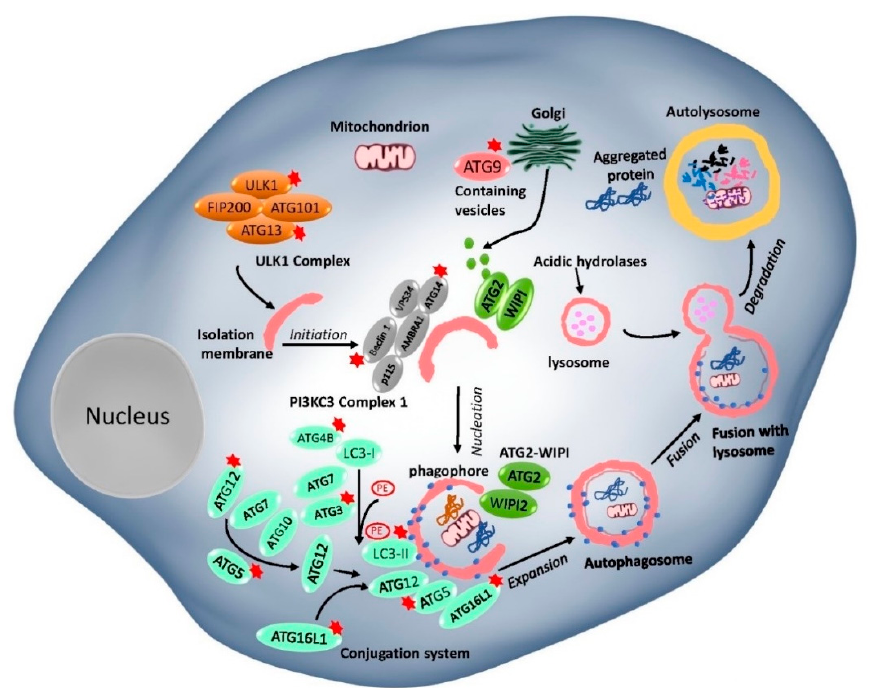
Figure 1. The mammalian core machinery of autophagy and target genes for Hepatocellular carcinoma (HCC) treatment. The core machinery comprises of ATG proteins formed five functional groups. (I) The ULK1 complex, consisting of ULK1, RB1-inducible coiled-coil protein 1 (FIP200), ATG101, and ATG13, which negatively regulates the mTOR complex. (II) The Beclin 1-class III PI3K